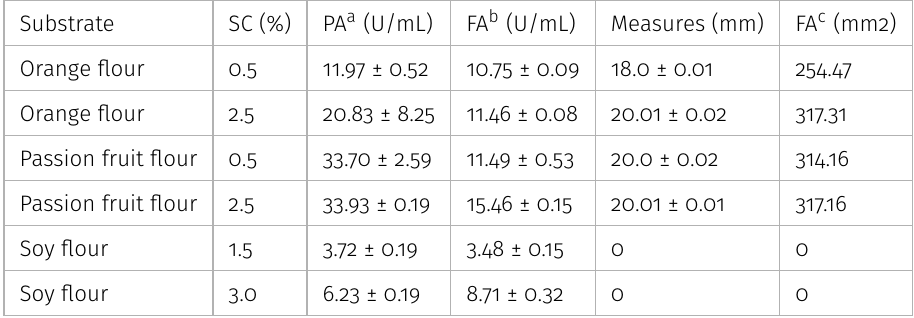
Table II. Production of fibrinolytic enzyme by Streptomyces parvulus DPUA 1573 using different substrates in liquid